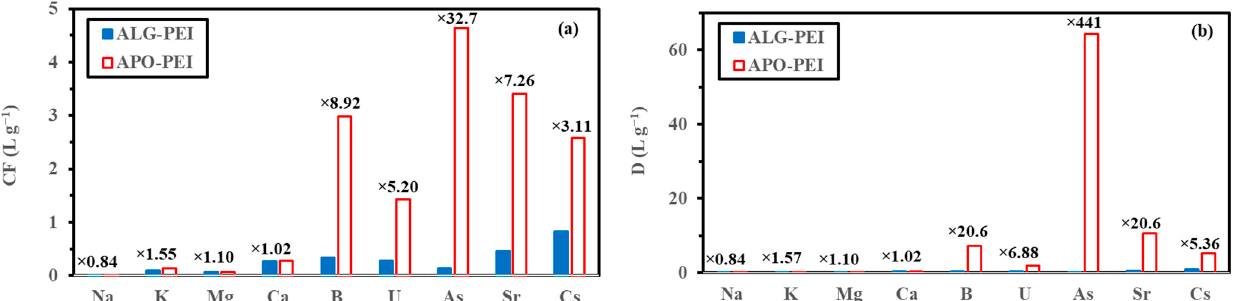
Figure 6. Concentration factor (C = q eq /C 0 , L g − 1 ) ( a ) and distribution ratio (D = q eq /C eq , L g − 1 ) ( b ) for selected elements for the treatment of the seawater sample using ALG-PEI and APO-PEI sorbents (for initial concentrations, see Table A8; SD: 0.2 g L − 1 ; pH 0 : 7.59; pH eq : 7.51; time: 24 h; v: 210 rpm; T: 21 ± 1 °C; individual numbers represent the enhancement factor associated with the functionalization of ALG-PEI sorbent).